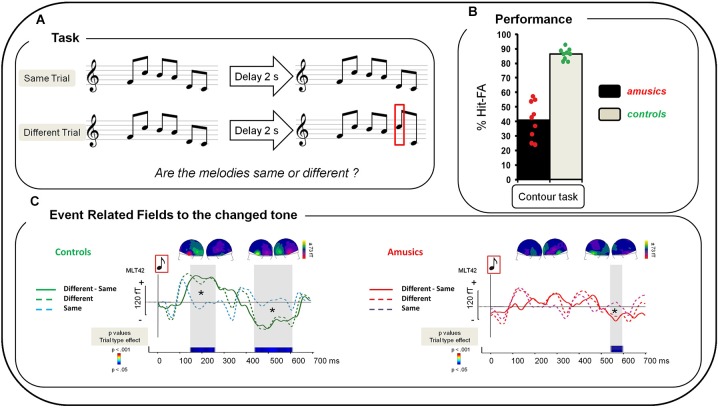
(A) Examples of the musical stimuli. “Same” trials: After a 2 s delay, S1 was repeated as the second melody of the pair (S2). “Different” trials: one tone was changed in the second melody of the pair (red square). (B) Performance of amusic and control groups (Gray, Controls; Black, Amusics) in terms of percent of Hit-FA. Green circles: controls’ individual performance; red circles: amusics’ individual performance. (C) Grand average of a left temporal MEG sensor (MLT42) for a 0–700 ms time window after the onset of the changed tone in S2 for the Contour Task for each group and each type of trial. Left: For controls. Green dotted line: “Different” trials, correct responses; blue dotted line: “Same” trials, correct responses; green plain line: “Difference Wave” (“Different” trials—“Same” trials for correct responses). Right: For amusics. Red dotted line: “Different” Trials, correct responses; purple dotted line: “Same” trials, correct responses; red plain line: “Difference Wave” (“Different” trials—“Same” trials for correct responses). Sensor plots correspond to the mean event-related fields (ERFs) of the “Difference Wave” in the 150–250 ms and the 400–600 ms time-windows for the change tone (average of all participants of each group).Two-sample t-tests were performed at each time sample on sensor amplitudes in the 0–700 time window in the two groups of participants. p-values are reported across time in the lower panel with blue for p < 0.05; green for p < 0.01; and red for p < 0.001. Note that only effects lasting longer than 15 ms were reported. See Albouy et al. (2013a) for details.